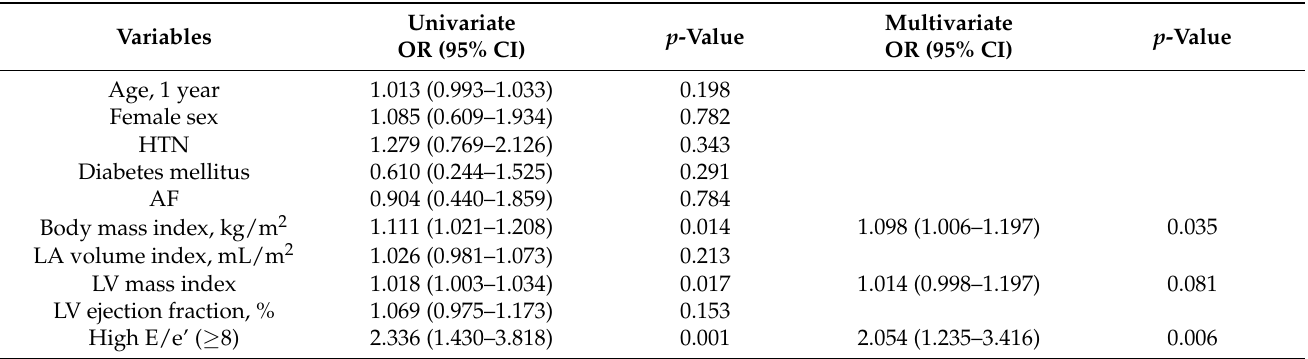
Figure 3. Correlation between left atrial pressure and E/e’ ( A ) at baseline and ( B ) at a heart rate of 150 bpm. LA, left atrial. Table 1. Predictors of high LA pressure response (LA pressure >26 mmHg) on univariate and multivariate analysis.